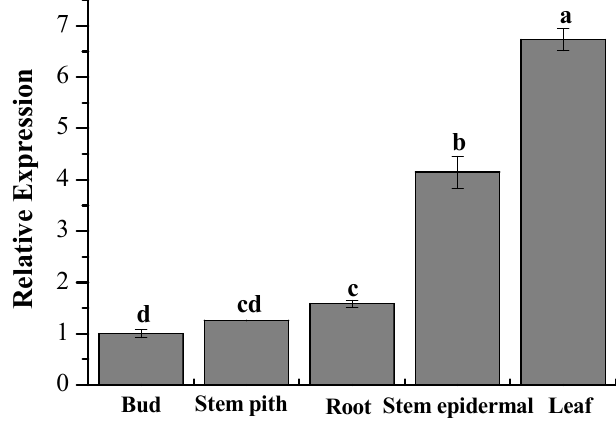
Figure 8. Tissue-specific expression analysis of the ScChi in different tissues of sugarcane cultivar Yacheng05-179. Data are normalized to the GAPDH expression level. All data points are the means ± SE ( n = 3). Different lowercase letters indicate a significant difference, as determined by the least-significant difference test ( p -value <